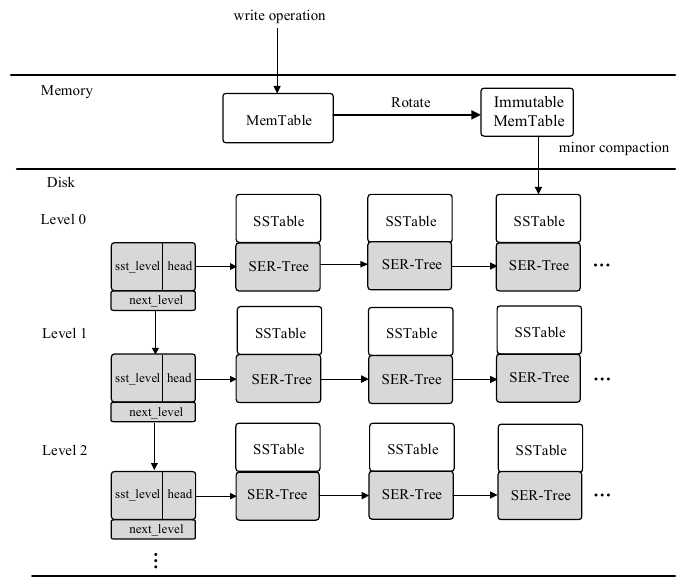
Figure 6. ER-tree index structure for spatial data on LSM-trees.